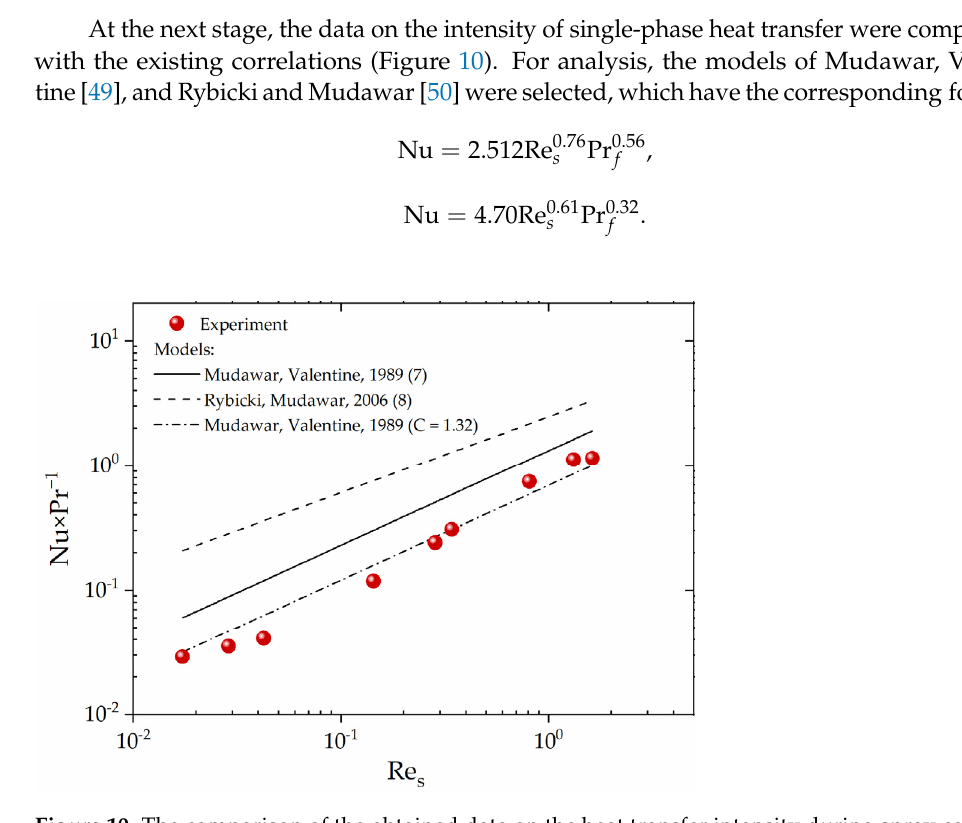
Figure 10. The comparison of the obtained data on the heat transfer intensity during spray cooling with the existing correlations ( q = 45 kW/m 2 ). with the existing correlations ( q = 45 kW/m 2